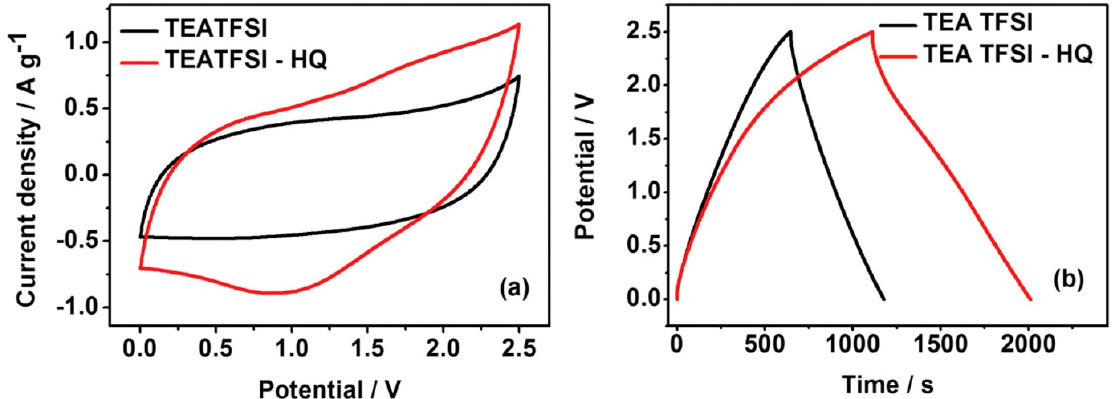
Figure 10. ( a ) Cyclic voltammograms of the SC at 10.0 mV s − 1 ; ( b ) galvanostatic charge–discharge at 0.57 mA cm − 2 in neat [TEA][TFSI] and [TEA][TFSI]/HQ (0.3 M). Reprinted 2015 from [143] with permission from Elsevier.